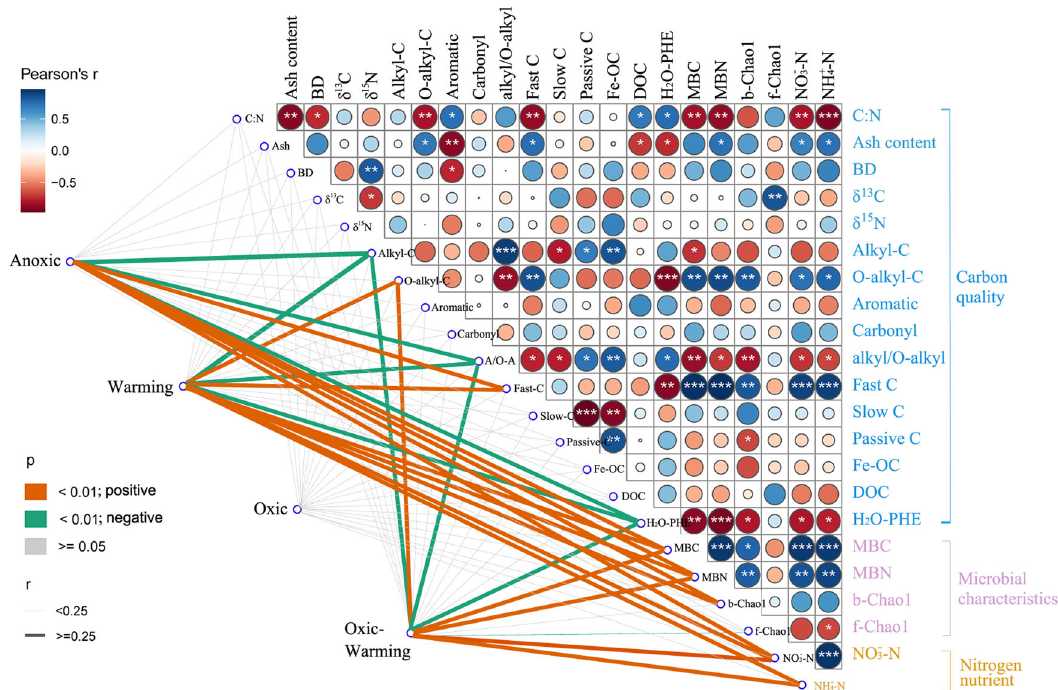
Fig. 6 Correlations between CO 2 emission rate and soil properties under different oxygen and temperature conditions. Line width re fl ects the Pearson correlation coef fi cient, while line color re fl ects the nature of the correlation (positive or negative) and the associated p value. In the matrix of pairwise comparisons, Pearson correlation coef fi cients are indicated using a color gradient. *** p < 0.001, ** p < 0.01, * p < 0.05. BD bulk density, A/O-A ratio of alkyl- C to O-alkyl-C, DOC dissolved organic carbon, H 2 O-PHE water-soluble phenolics, Fe-OC, Fe-bound organic carbon, MBC microbial biomass carbon, MBN microbial biomass nitrogen, b-Chao1 Chao1 richness of bacteria, f-Chao1 Chao1 richness of fungi.